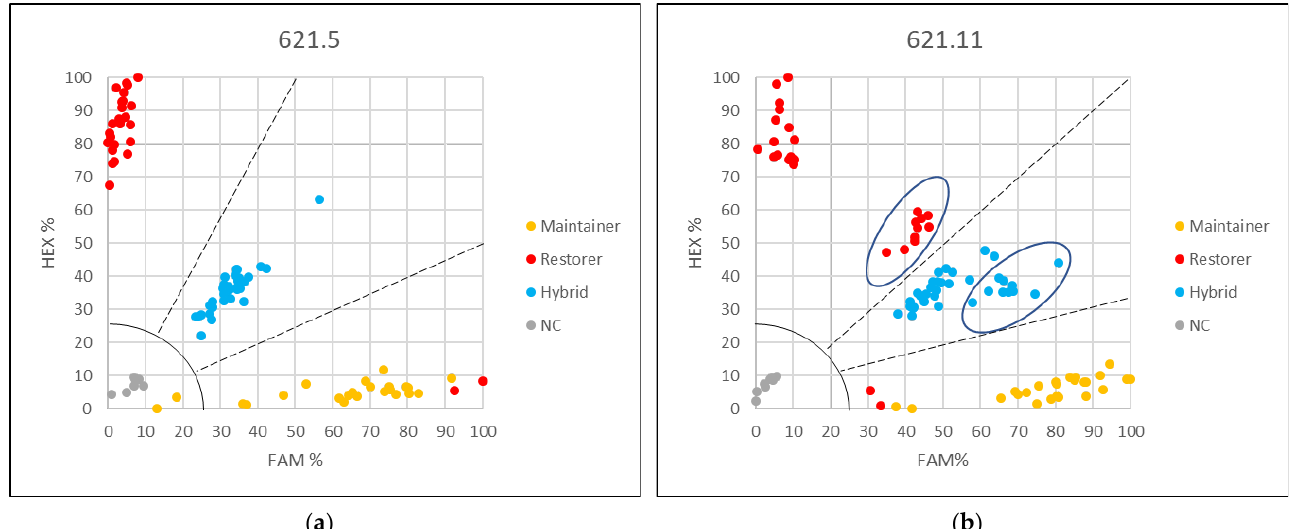
Figure 2. Grouping obtained by KASP markers ( a ) 621.5 and ( b ) 621.11. The latter splits the restorer lines into two groups. However, the outgroup of restorer lines (marked by an oval) can still be separated from their crosses to the CMS tester (also marked by an oval). NC negative control.